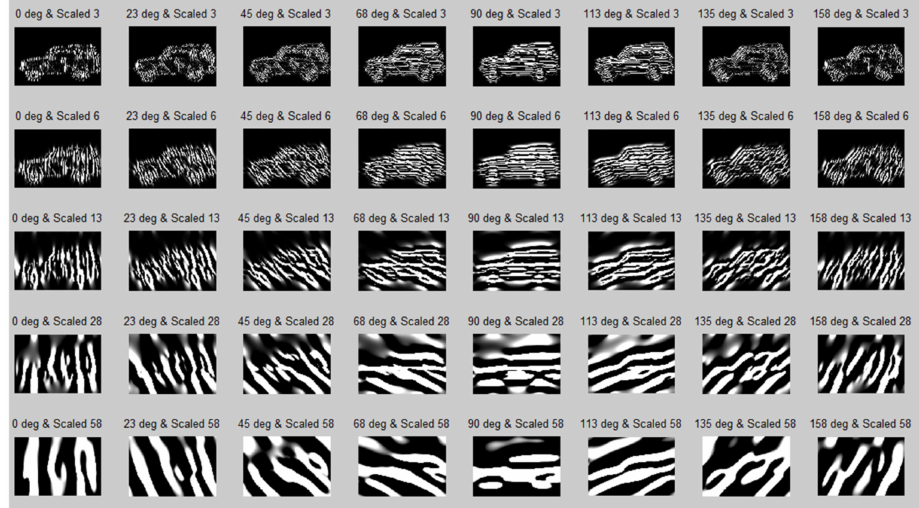
Figure 6. The convolution operation of a Gabor filter with an